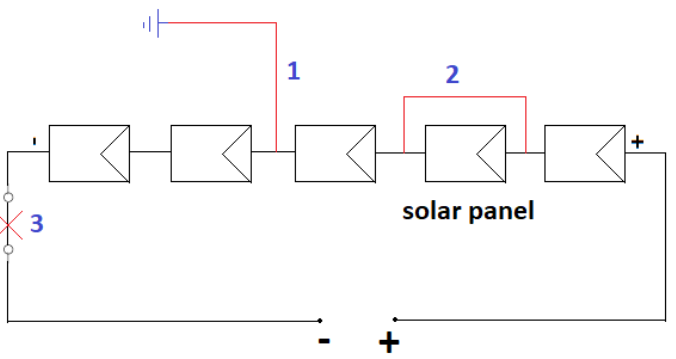
Figure 3. Types of electrical failures analyzed in this research. (1) Short circuit to ground, (2) Short circuit in PV module and (3) Open